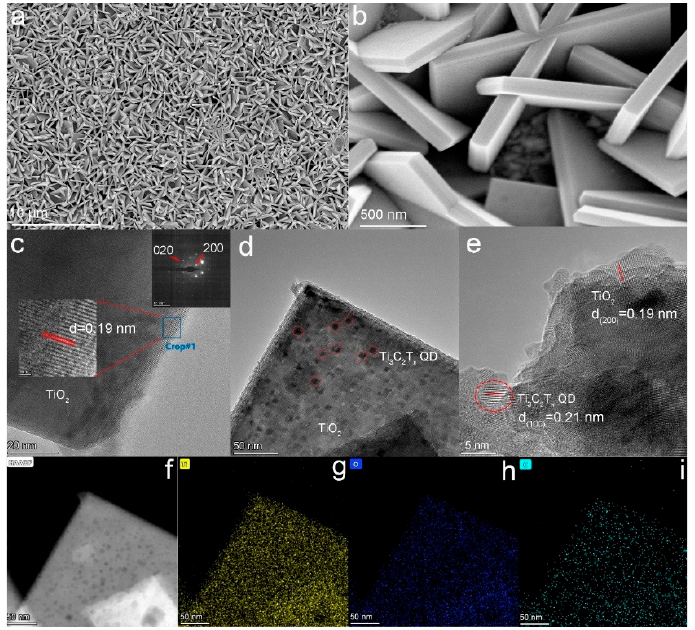
Figure 2. ( a , b ) FESEM of Ti 3 C 2 T x QDs/(001) TiO 2 ; TEM of ( c ) (001) TiO 2 inset (middle part, HRTEM image, top right-hand corner, SAED) and ( d ) Ti 3 C 2 T x QDs/(001) TiO 2 ; ( e ) HRTEM of Ti 3 C 2 T x QDs/(001) TiO 2 ; and ( f – i ) mapping of Ti 3 C 2 T x QDs/(001) TiO 2 (( g ): Yellow, titanium; ( h ): blue, oxygen; ( i ): cyan, carbon).